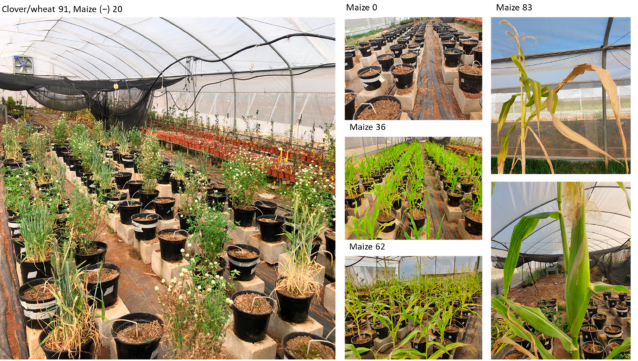
Figure 6. The greenhouse pot experiment—representative photos. The experiment is described in Figure 1. Numbers indicate days from sowing.